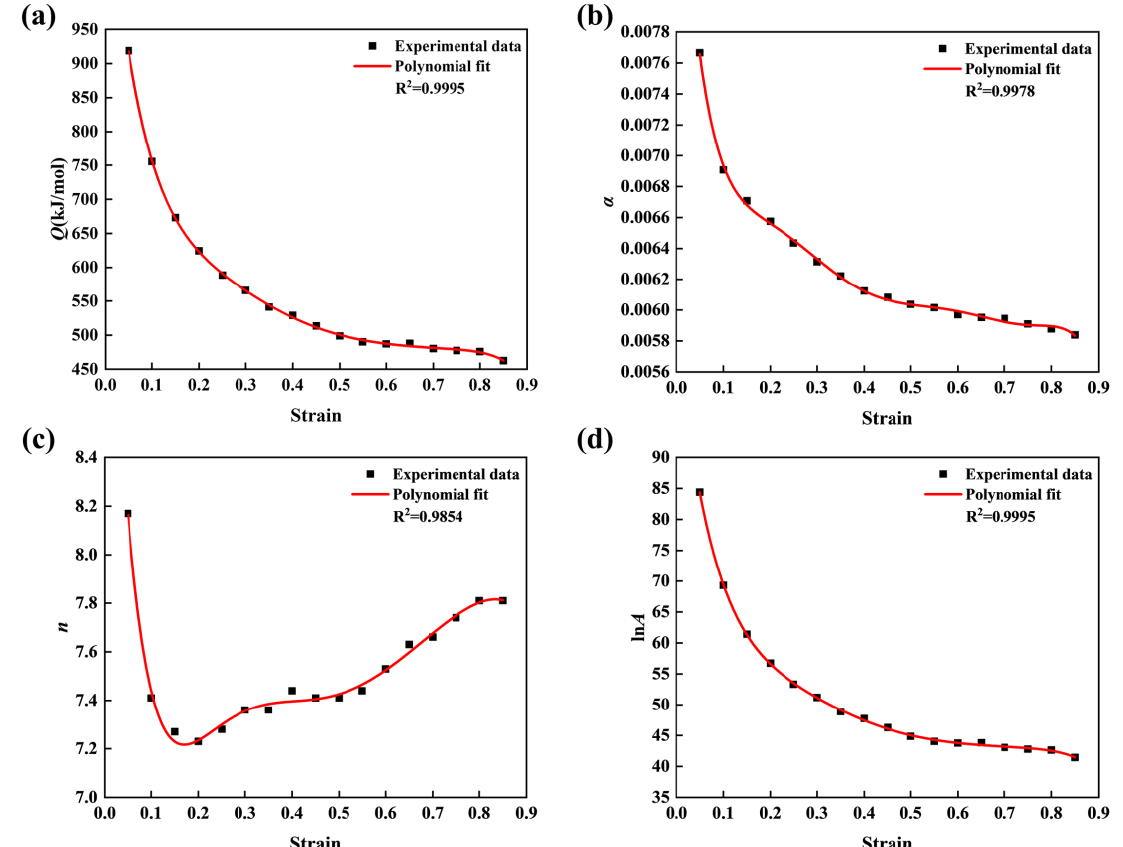
Figure 4. The calculation flow chart of the material-dependent constants related to the constitutive equation.